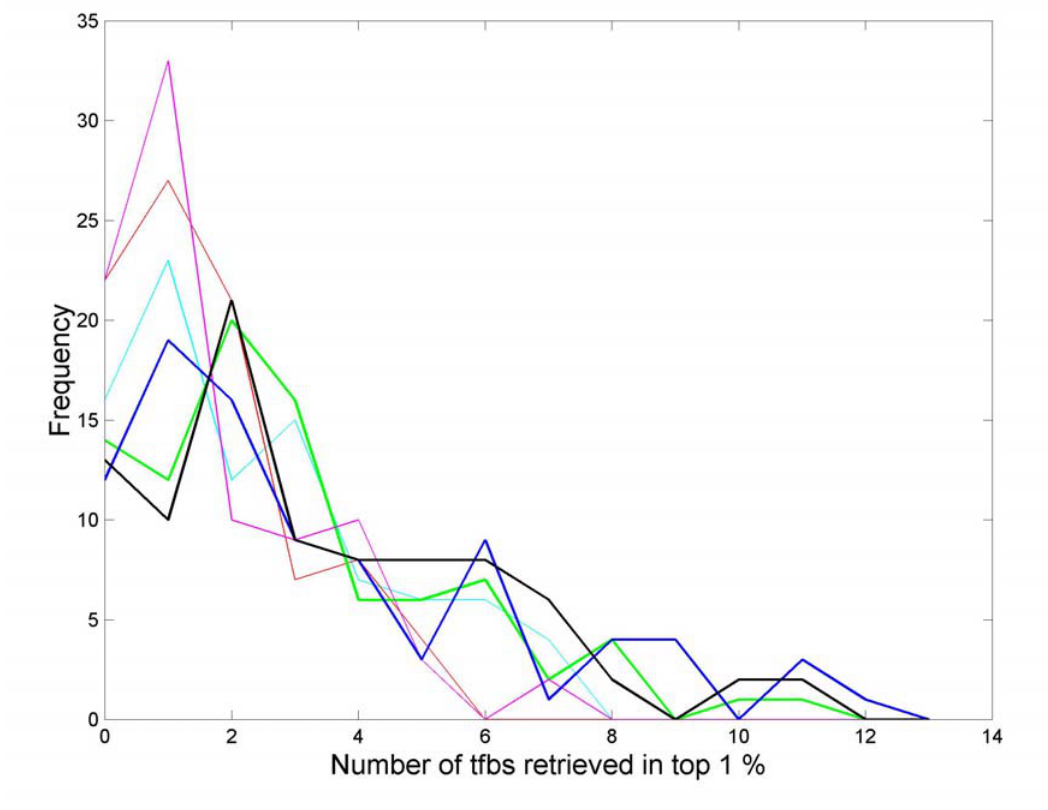
Figure 10. Data fusion retrieval. Single parameters : groove (cyan); k – (green); groove + k – (magenta). Fused parameters: groove + k – Twist + roll3 + 3Q + + sequence groove + k – Twist Twist